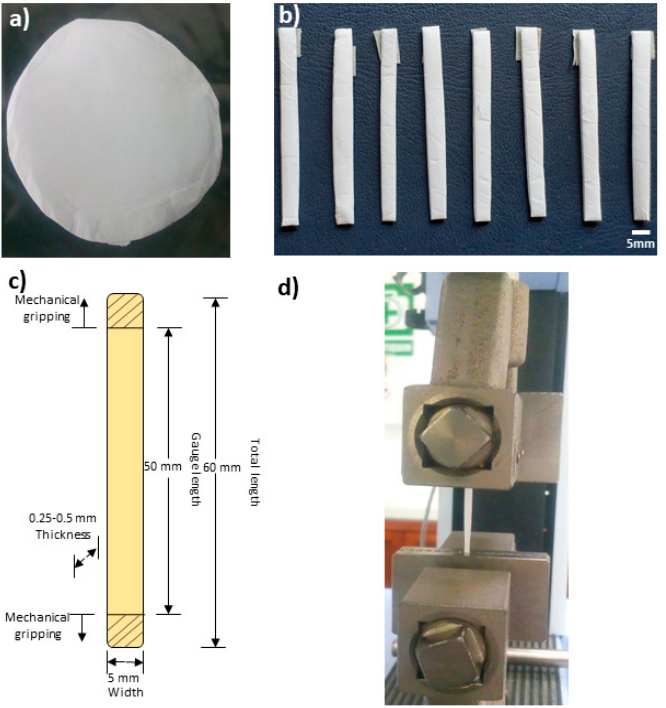
Figure 1. ( a ) Polycaprolactone (PCL) scaffold obtained by electrospinning, ( b ) tensile specimens according to the ASTM D822 standard, ( c ) specimen dimensions, and ( d ) holding the specimen in the tensile machine.